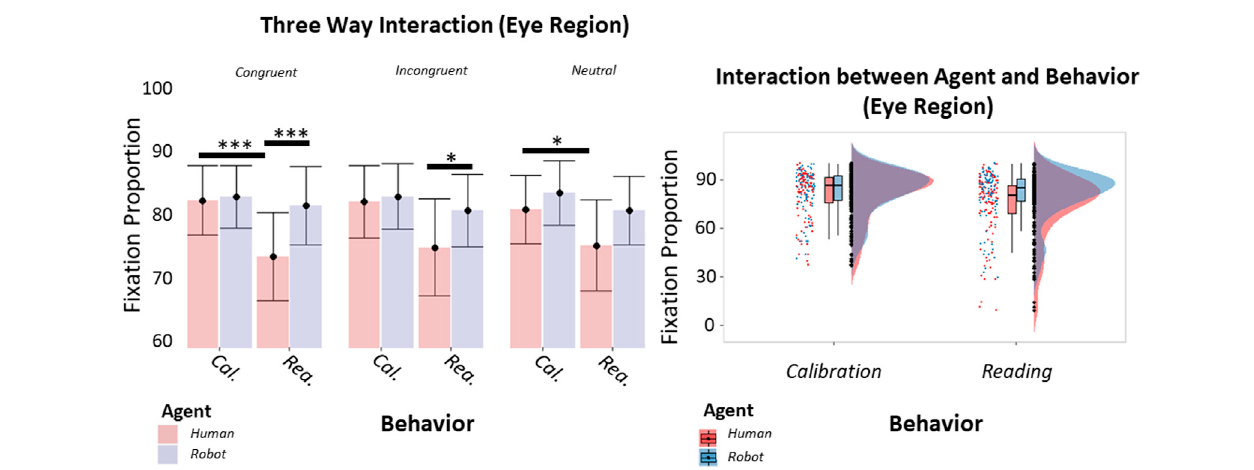
FIGURE 3 | Histograms and raincloud plots showing respectively the thee-way interaction between Agent, Behavior, and Context (A) and the two-way interaction betweenAgentandBehavior (B) (GLM).Verticalbarsofthehistogramsdenote ± 1standarderror,dotsdenotemeanvalues,horizontalbarsdenotedifferencessurviving post hoc comparison. Asterisks de fi ne the level of signi fi cance of the comparison (* p < 0.05, ** p < 0.01, p < 0.001). Boxplots associated with the raincloud plots depict median values (black horizontal lines), interquartile ranges (black boxes), and upper-lower quartile intervals (black whiskers).